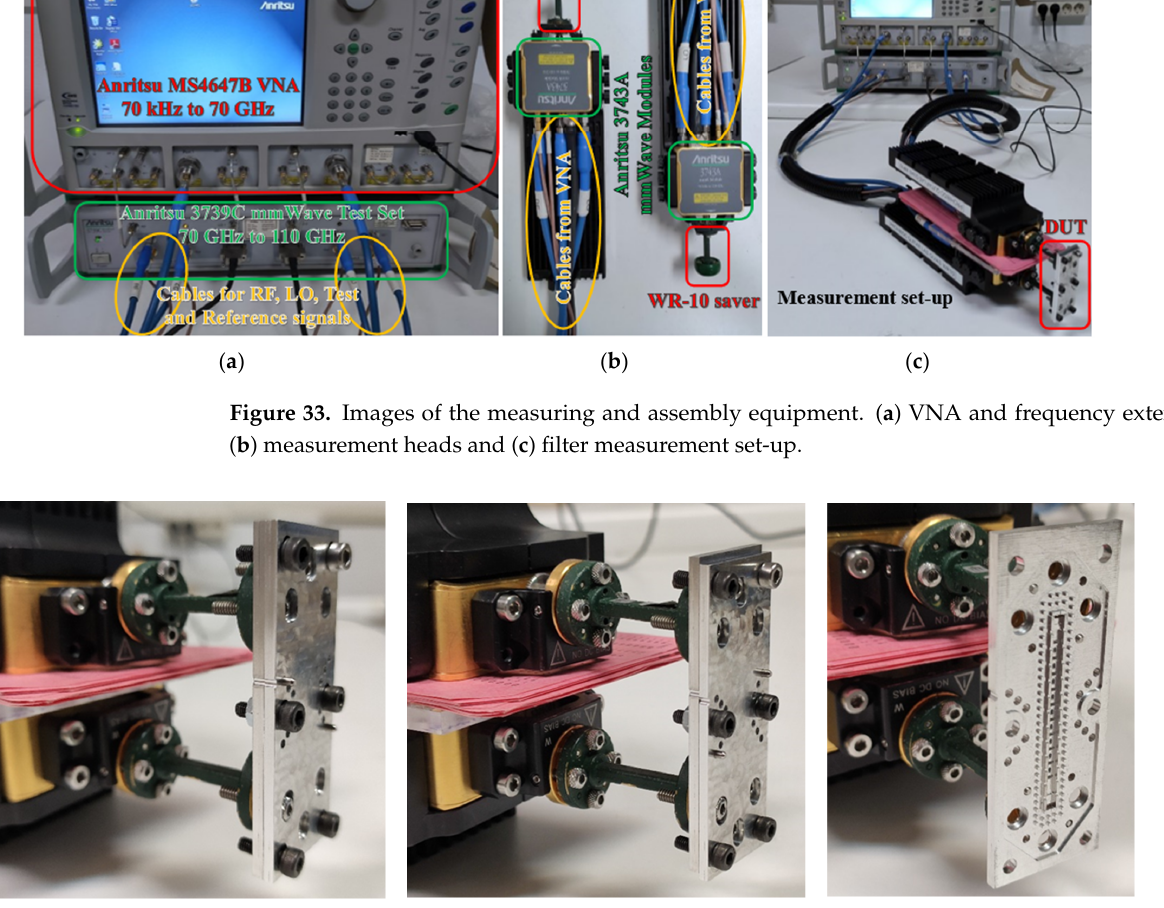
Figure 34. Detailed view of the filter assembly for measurement. ( a ) Filter in glide symmetry position, ( b ) filter in maximum symmetry breaking position and ( c ) view of the inside of the filter connected to the WR-10 flanges.